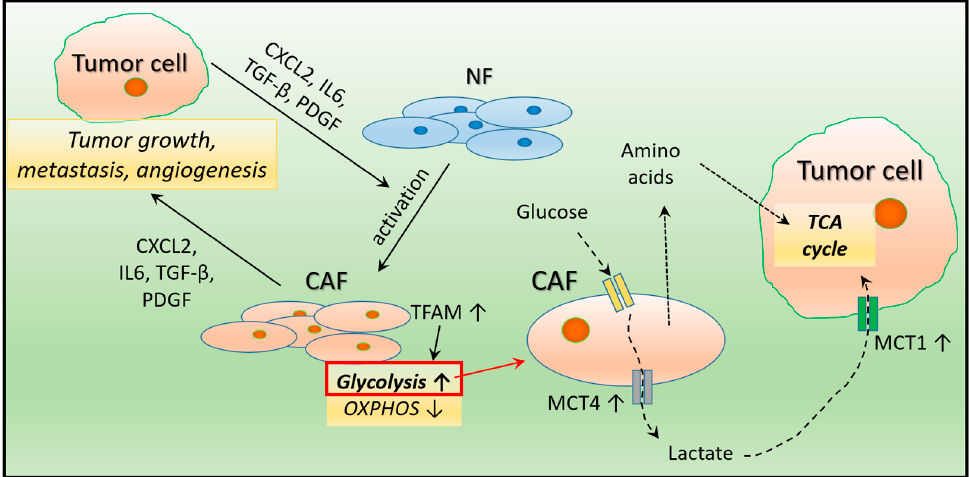
Figure 1. The effect of tumor cells on fibroblast reprogramming. The substances secreted by tumor cells convert normal fibroblasts in the environment into cancer-associated fibroblasts (CAF), which support tumor cell growth, metastasis, and angiogenesis. In CAF cells with increased glycolysis, uptaken glucose is converted to lactate, which is driven by increased efflux to tumor cells through higher MCT4 (monocarboxylate transporter 4) levels. In turn, higher MCT1 levels in tumor cells allow for increased lactate uptake, which is then utilized in the mitochondria via the TCA (tricarboxylic acid) cycle. The amino acids produced by CAF cells offer tumor cells another opportunity for energy utilization. NF: normal fi broblast.